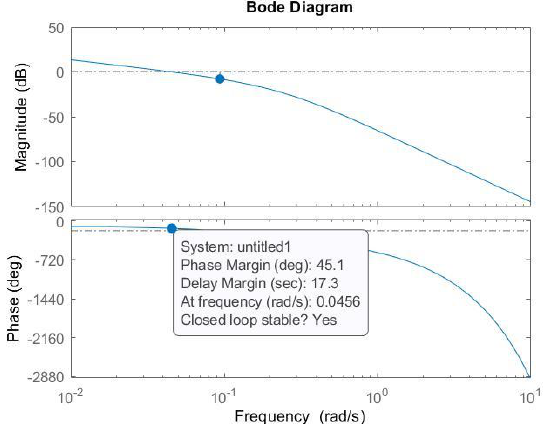
Figure 2. Bode diagram of the open-loop system for the first designed PI controller.